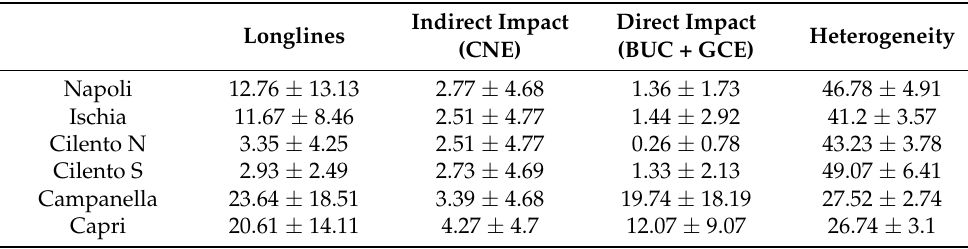
Table 3. Mean ( ± SD) of linear regression independent (longlines) and dependent variables (direct impact, indirect impact, and